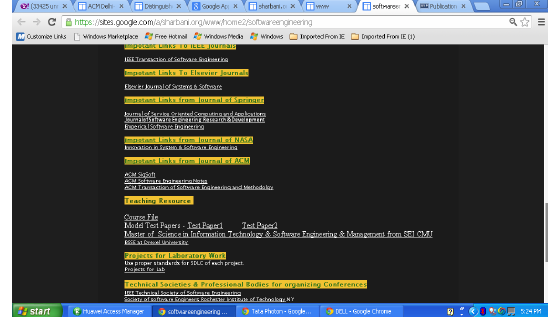
Figure 4. Teaching Resources, Journals & Lab